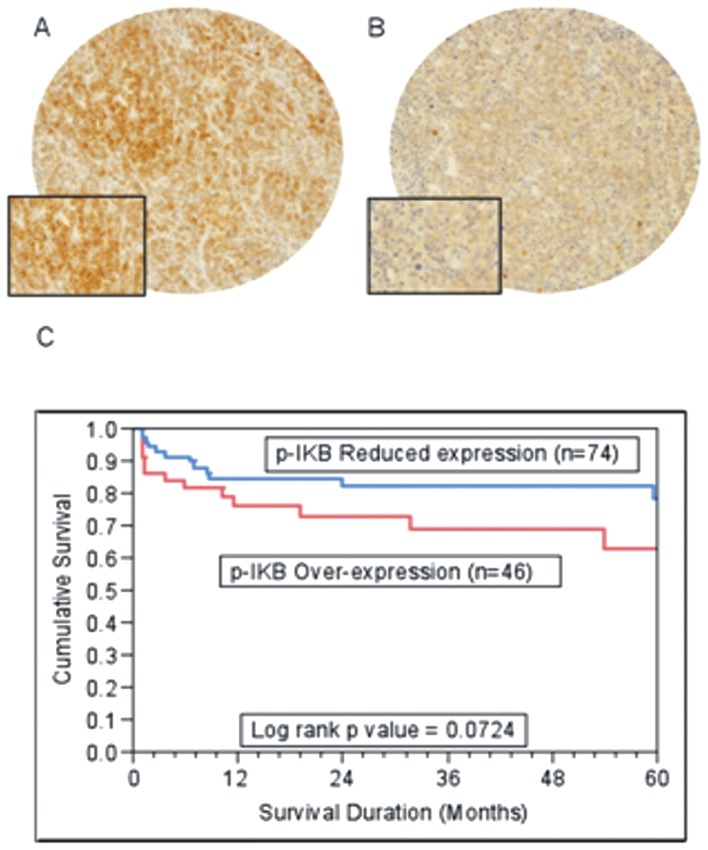
Tissue microarray based immunohistochemical analysis of p-IκB expression in DLBCL patients: DLBCL array spot showing high expression of p-IκB (A) and low expression of p-IκB (B).20×/0.70 objective on an Olympus BX 51 microscope. (Olympus America Inc, Center Valley, PA, USA. with the inset showing a 40×0.85 aperture magnified view of the same. (C). Impact of p-IκB expression on prognosis in ABC patients. In patients with activated B cell phenotype(ABC) subgroup, p-IκB over expression showed a poor overall survival of 56.3% at 5 years as compared to 78.2% with low p-IκB expression (p = 0.0724).